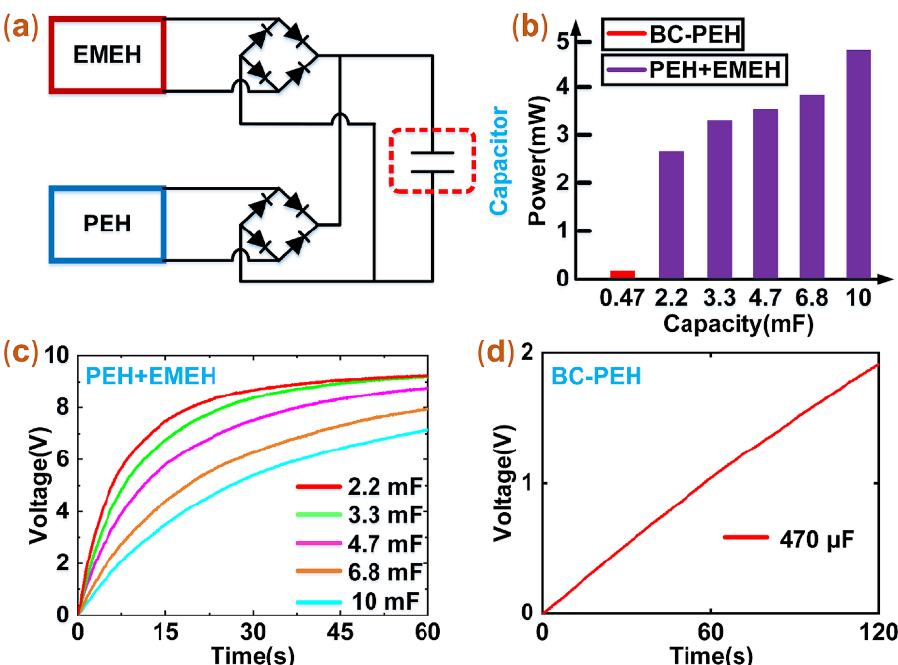
Figure 8. The experimental circuit and results of charging capacitors. ( a ) The circuit of charging capacitors. ( b ) The histogram of the average charging power. ( c ) The results of charging capacitors by using the hybrid harvester. ( d ) The result of charging capacitor by using the BC-PEH.